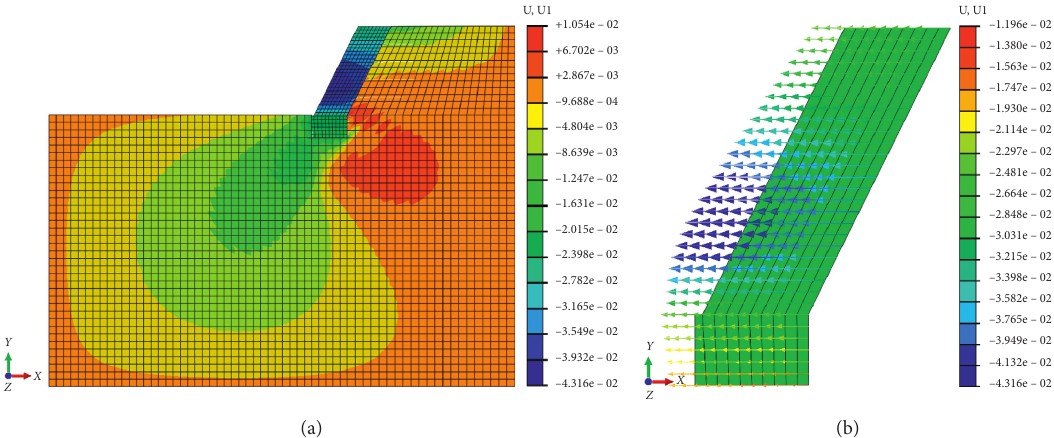
Figure 9: Lateral displacement distribution from numerical simulation results. (a) The geocell-reinforced retaining wall color nephogram. (b) The horizontal component of the retaining wall displacement vector.